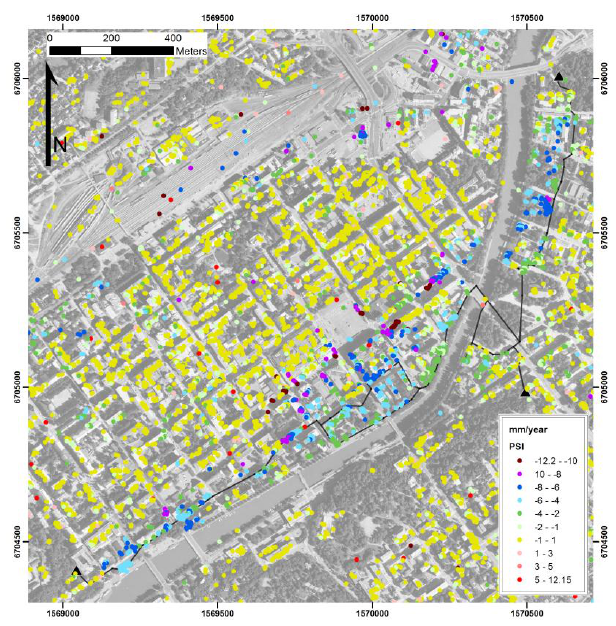
Figure 6. The PSI subsidence map of Turku. The vertical deformation rates are in mm/yr. The black line is the FGI leveling network, which includes three bedrock bolts (the black triangles). TC ≥ 0.6. The coordinates are in the Finnish National Coordinate System (KKJ). Aerial image © Turun kaupungin